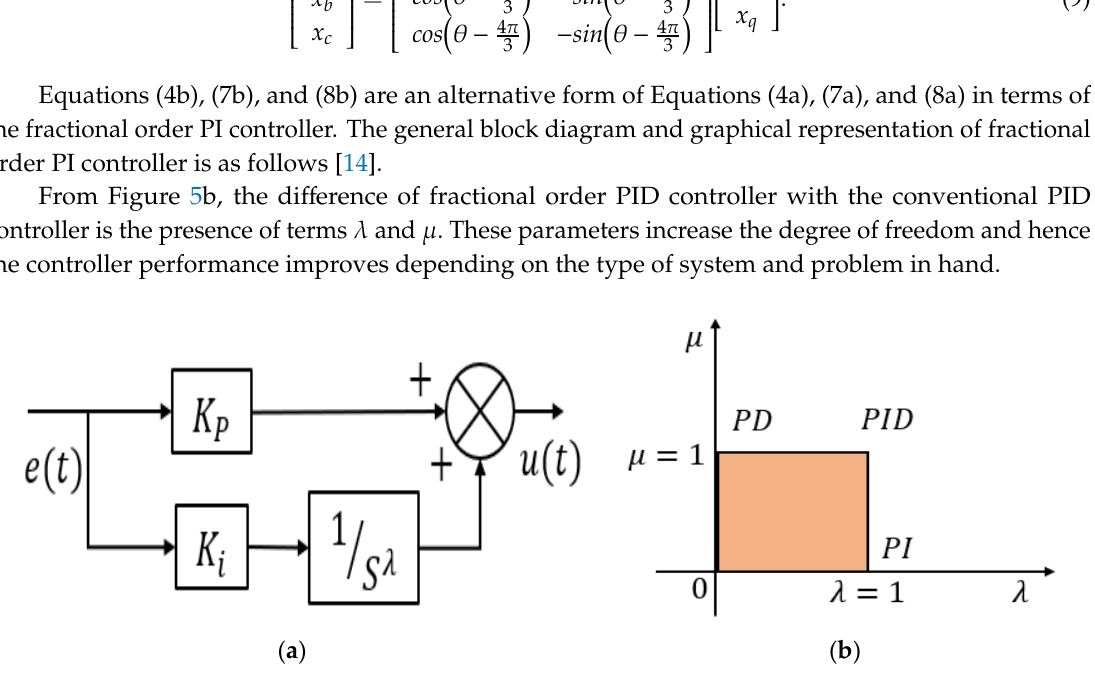
Figure 5. Fractional order PI controller: ( a ) block diagram; ( b ) graphical representation.